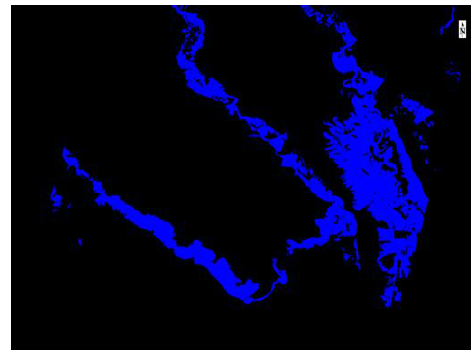
Figure 6. Ground truth